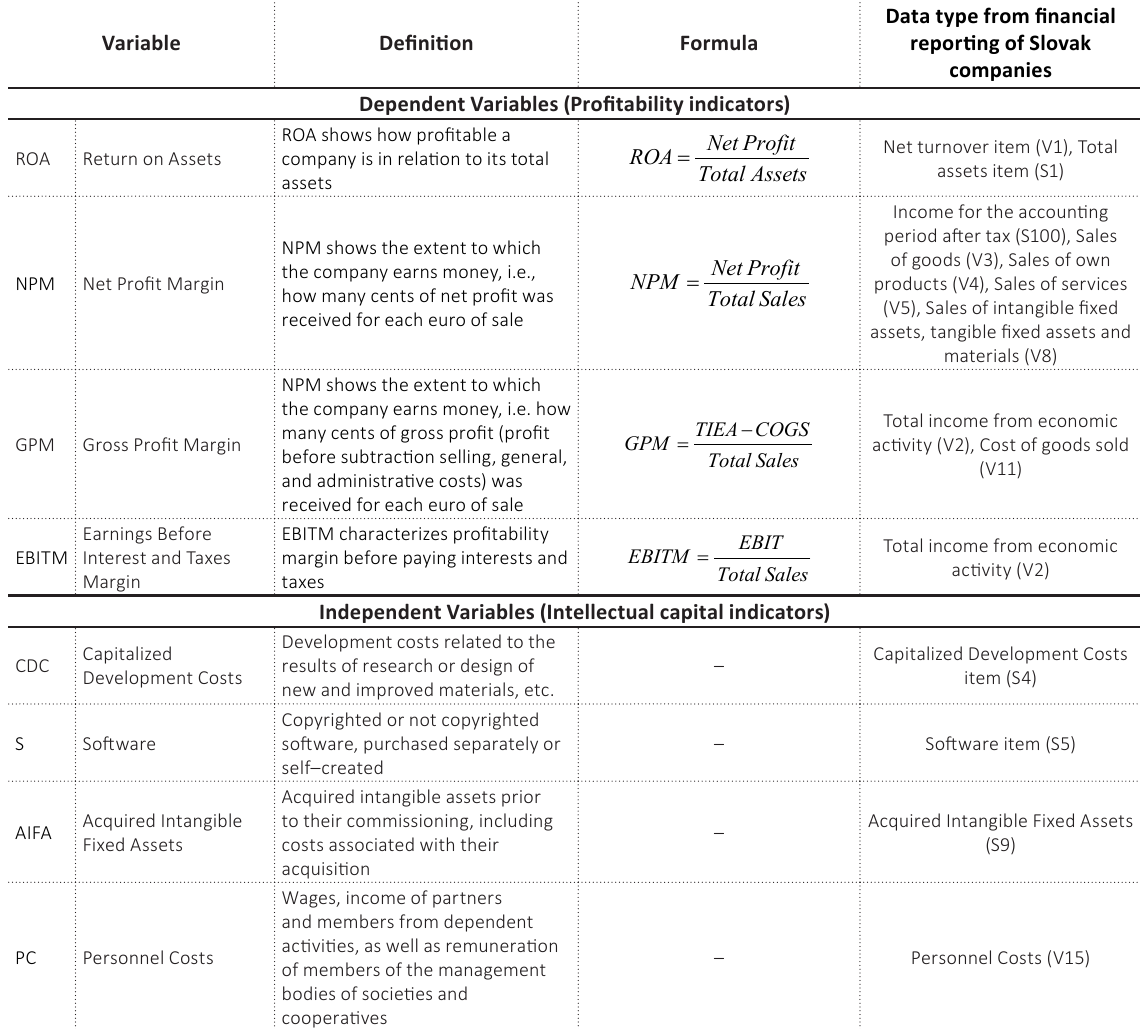
Table B1. Characteristics of dependent and independent variables for analysis of the relation between profitability and intellectual